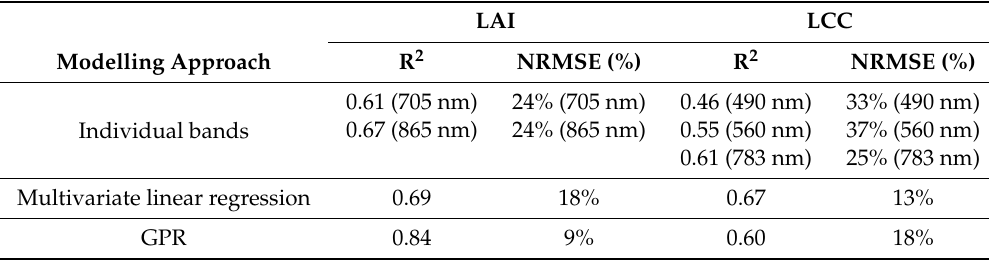
(R 2 = 0.61) with increasing LCC.